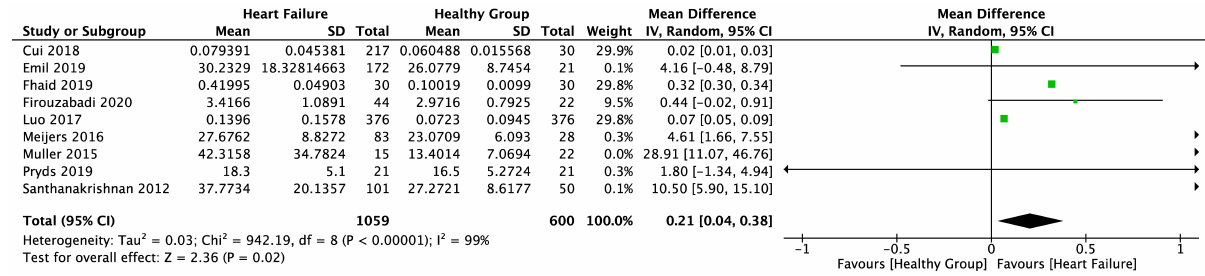
FIGURE 5 | Forest plot of sST2 levels between HF and healthy groups.